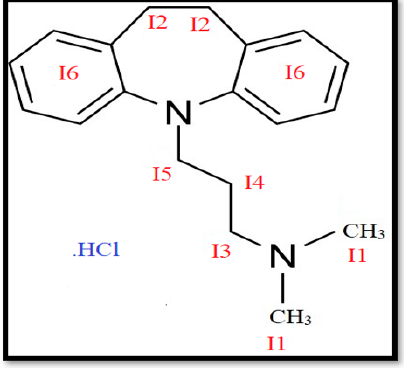
Scheme 2. Molecular model of drug IMP.